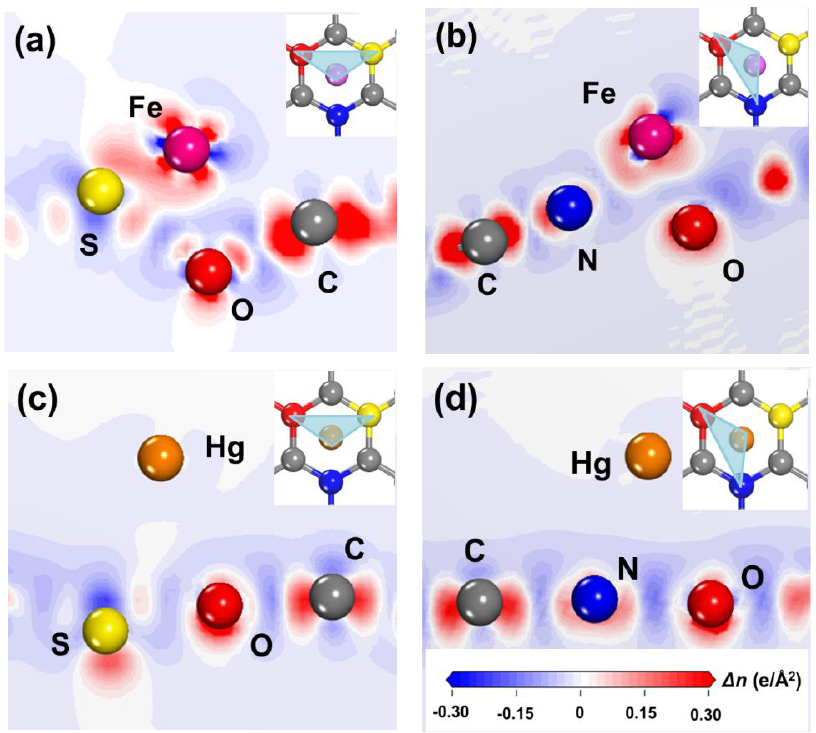
Figure 9. The electron density difference of N, S-GQDs after the adsorption of Fe 3+ ( a , b ) and Hg 2+ ( c , d ),